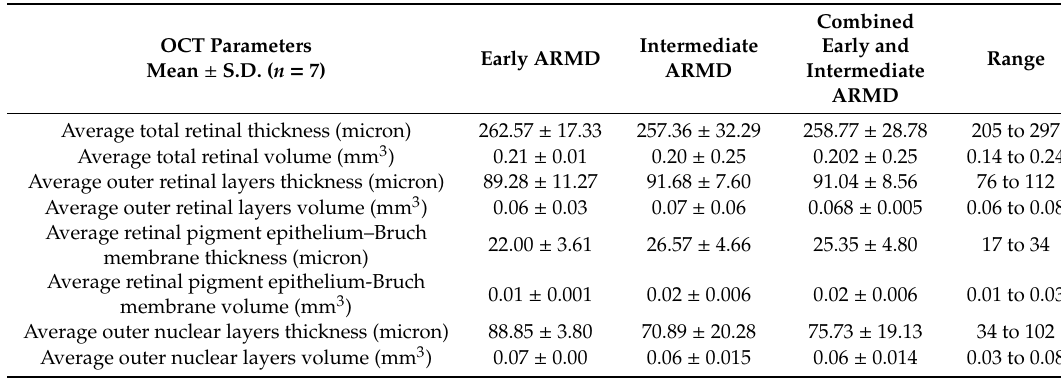
Table 3. Descriptive statistics of optical coherence tomography (OCT) parameters in eyes with early and intermediate